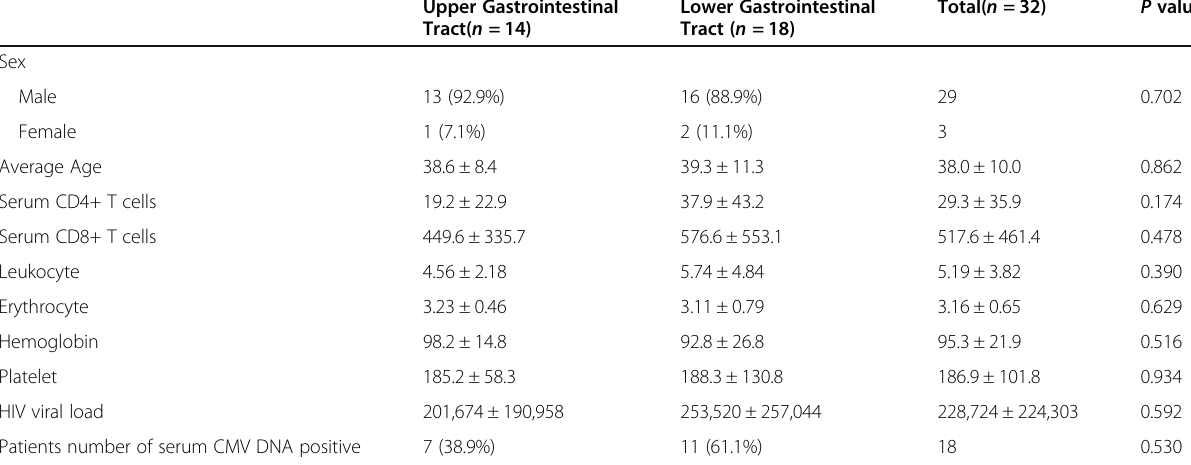
Table 1 Demographics and laboratory parameters of patients with gastroscopy and